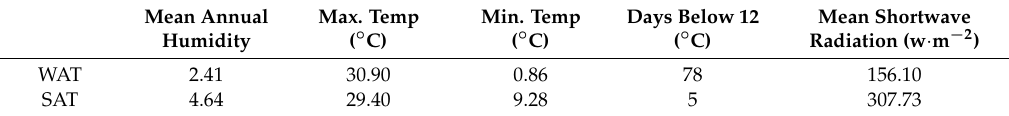
Table 2. Humidity, temperature parameters ( ◦ C), radiation in the reproduction stage.